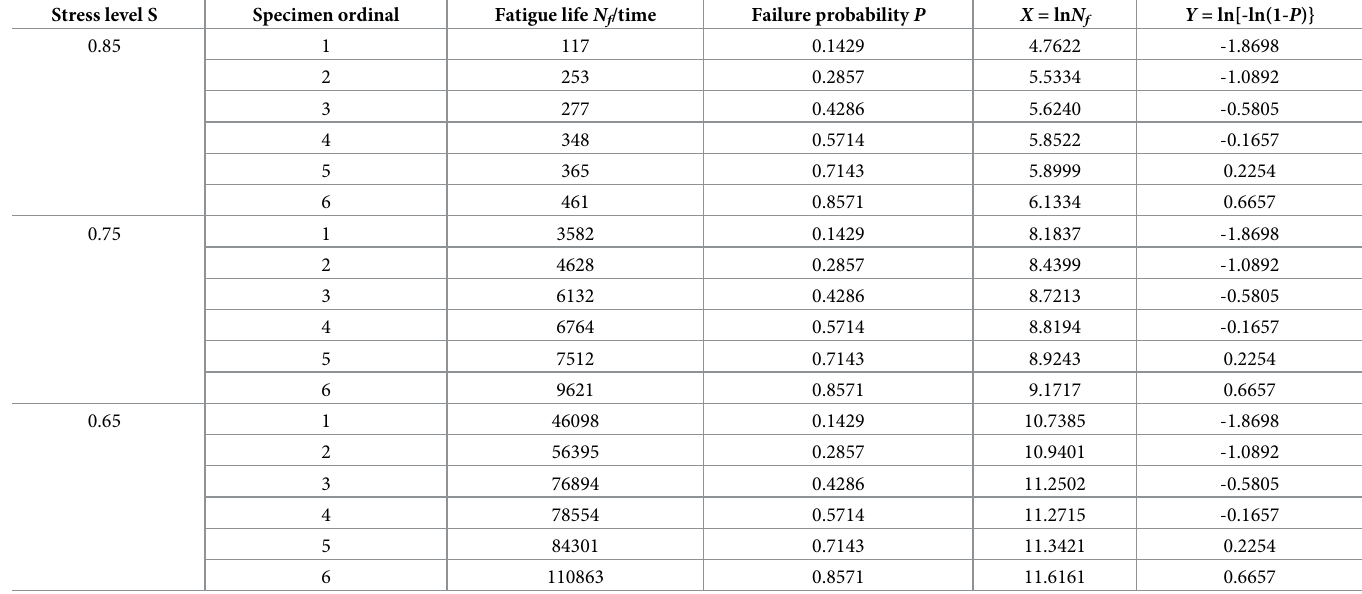
Table 7. Weibull distribution test for bending fatigue life of